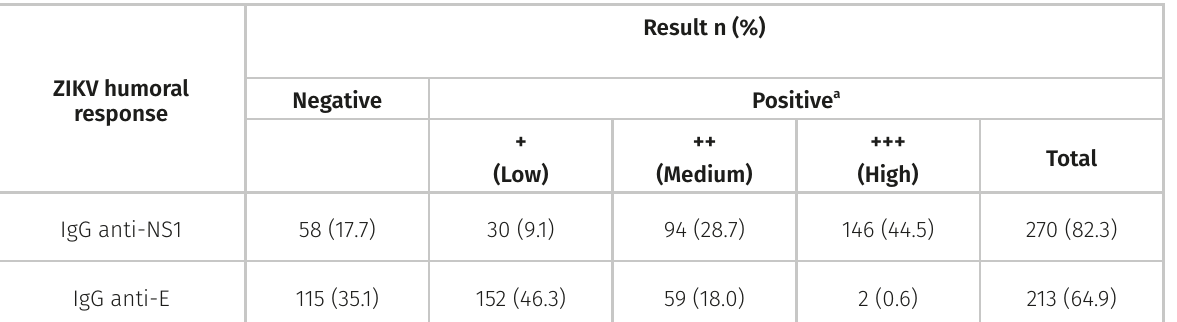
Table I. Zika flavivirus seroprevalence (n = 328).